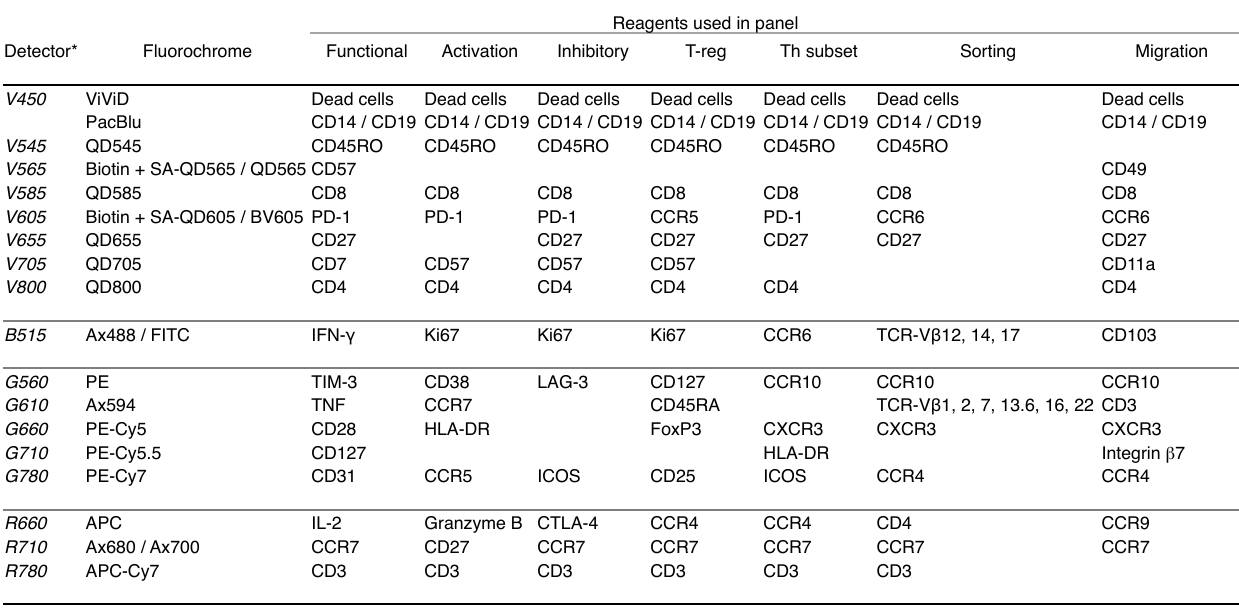
ViViD indicates LIVE/DEAD Þxable violet dead cell stain; PacBlu, paciÞc blue; QD, quantum dot; SA, streptavidin; BV, brilliant violet; Ax, alexa; FITC, ßuorescein isothiocyanate; PE, R-phycoeryhtrin; Cy, cyanine; APC, allophycocyanin . ! * Detectors are coded by laser colour (V indicates violet; B, blue; G, green; R, red) and mean wavelength measured.